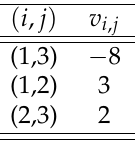
Figure 2. Graph G and valuations v i , j